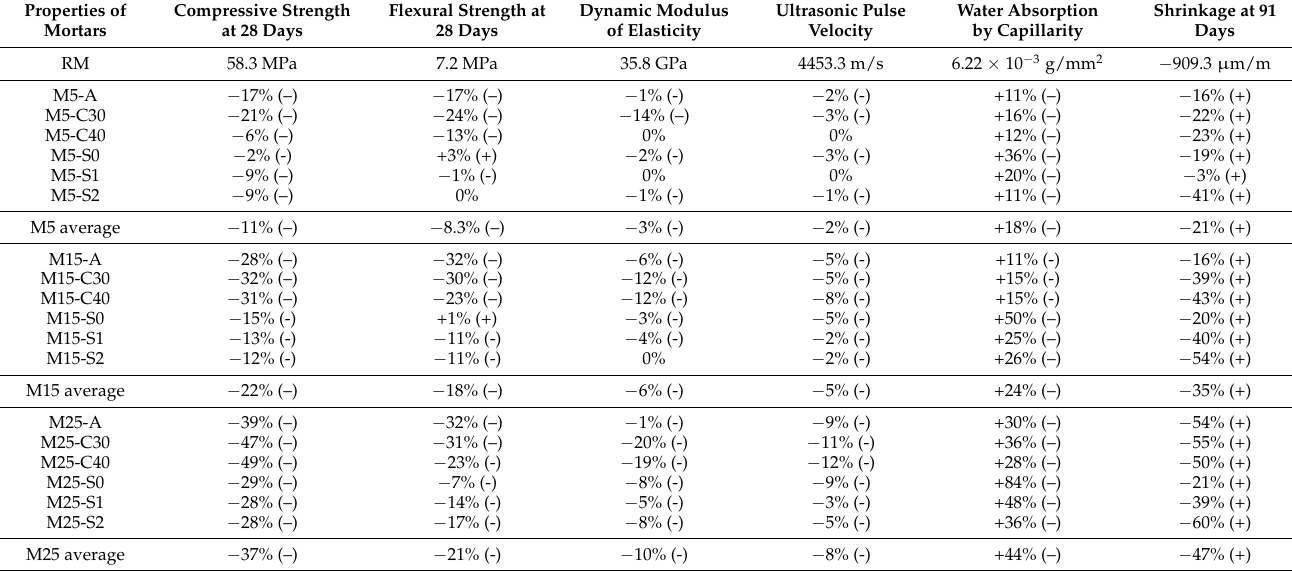
Table 2. Summary of mechanical and durability properties of mortars with cement substitution with MgO. Properties of